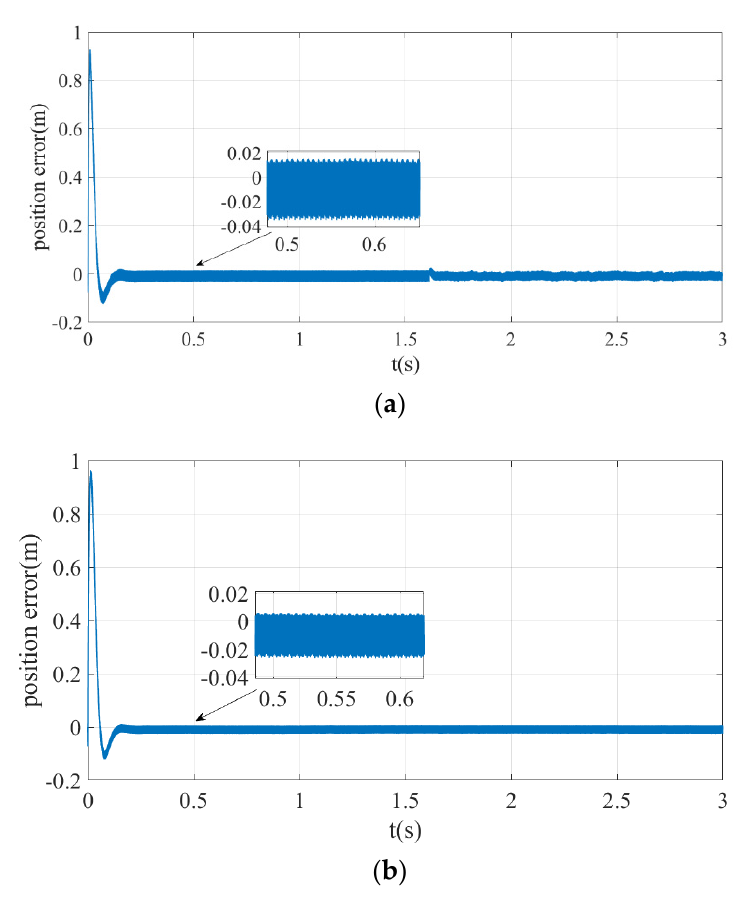
Figure 7. Speed estimation error. ( a ) EKF velocity estimation error. ( b ) AMEKF velocity estimation error.